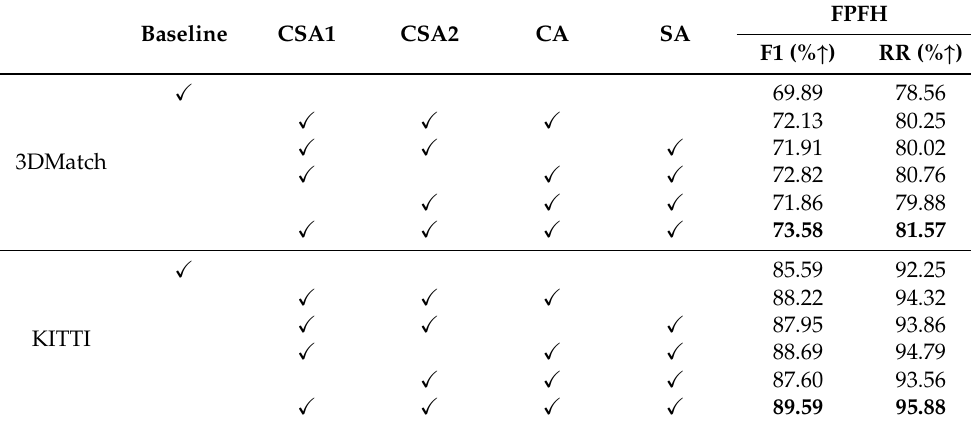
Table 5. Ablation study of CSC blocks on 3DMatch and KITTI datasets. Baseline: PointDSC [15]. CSA1: using the CSA layer. CSA2: using the CSA layer in the Nonlocal CSA layer. CA: using the channel attention module in CSA layers. SA: using the spatial attention module in CSA layers. The test results are combined with the FPFH descriptor.